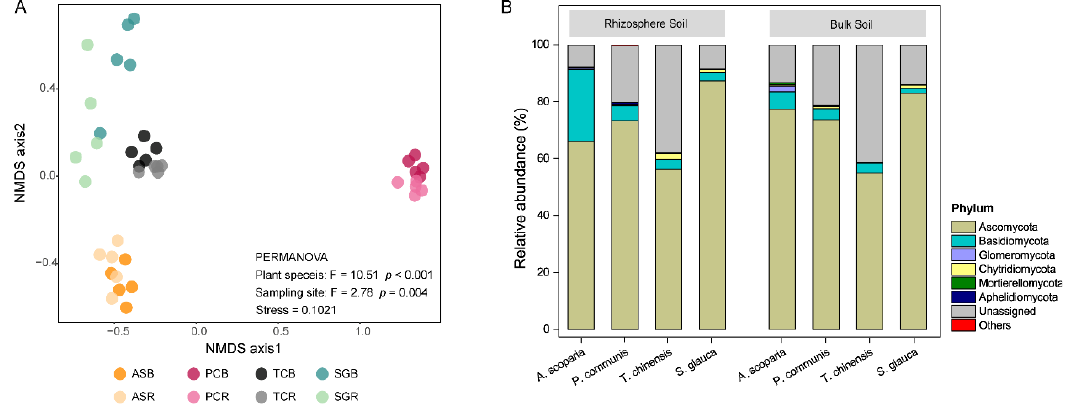
Figure 1. Soil fungal community composition in the rhizosphere and bulk soils of the four selected plant species. ( A ) Ordination of the soil fungal community composition based on operational taxonomic units (OTUs), as determined by non-metric multidimensional scaling (NMDS) ordinations using the Bray-Curtis similarity index. Stress = 0.102. ( B ) the relative abundance (%) of major taxonomic groups at the fungal phyla level. AS, A. scoparia ; PC, P. communis ; TC, T. chinensis ; SG, S. glauca ; R, rhizosphere; B, bulk